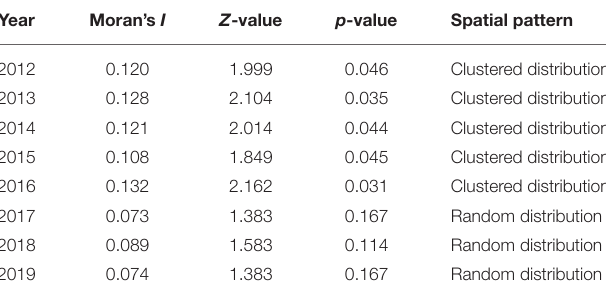
TABLE 4 | Global autocorrelation analysis of the coupling coordination degree of tourism development and medical